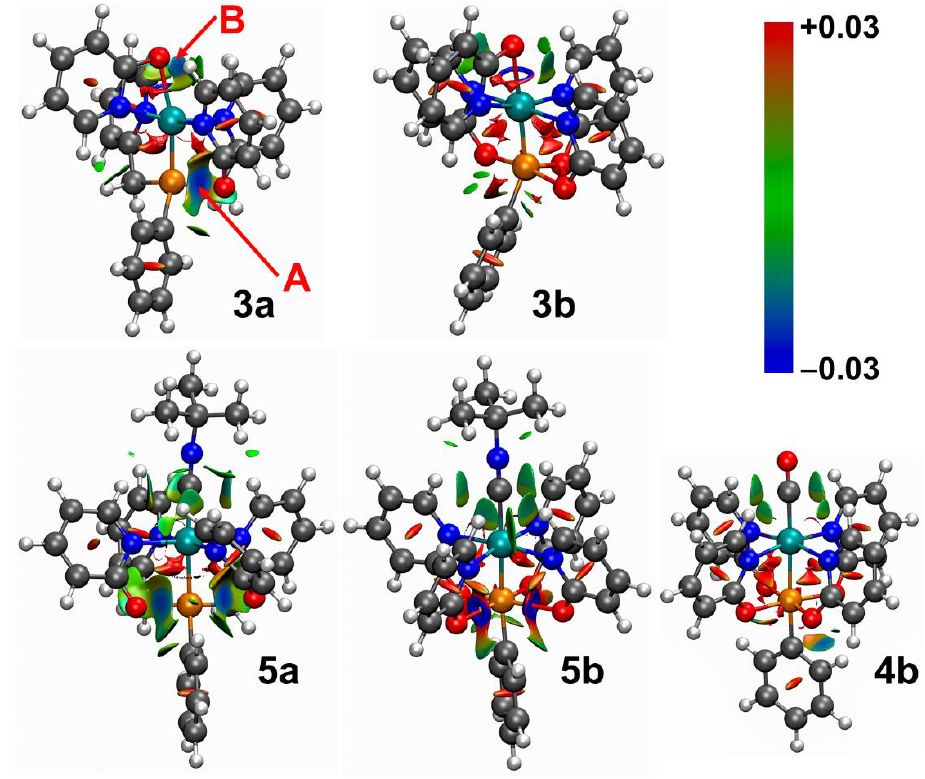
Figure 9. Non-covalent interactions descriptor (NCI) for compounds 3a , 3b , 4b , 5a and 5b with color scale (iso-value 0.45; blue zones indicate attractive interaction, red zones indicate repulsive interactions).